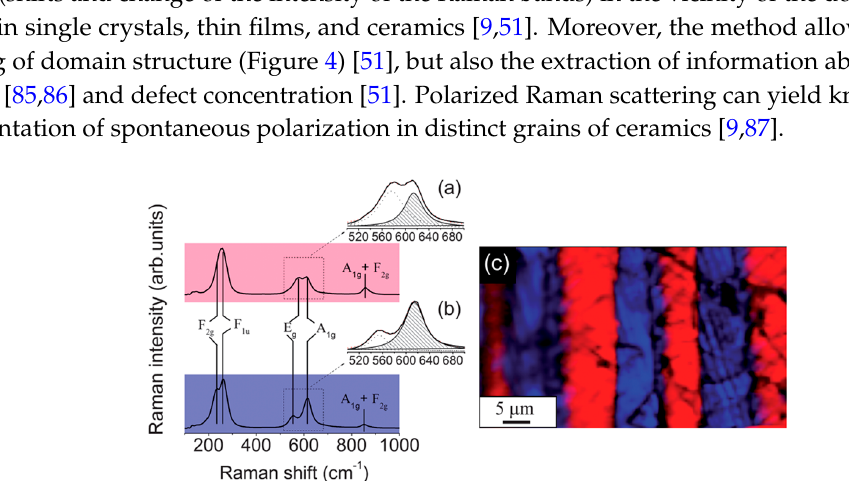
Figure 4. Characterization of KNN ceramics by confocal Raman spectroscopy: ( a , b ) Average Raman spectra of adjacent striped domains separated by a 90° domain wall. The insets show magnified Raman spectra and Lorentzian fits of domain structure in the frequency range between 500 and 700 cm − 1 . These spectra are fitted to the sum of two Lorentzian peaks, ascribed to the E g ( υ 2 ) and A 1g ( υ 1 ) Raman modes, respectively; ( c ) Raman map of domain structure of the KNN exhibiting clear differences between average spectra of adjacent striped domains separated by a 90° domain wall. The Raman map was derived by summing up the total spectral pixel intensity from 100 to 1000 cm − 1 . Adapted from [59], with permission from © 2012 Royal Society of Chemistry.